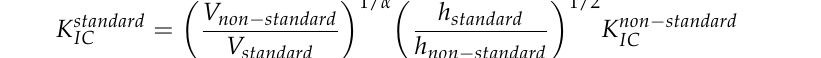
( c ) Figure 13. AE signal–time and stress–time curves of concrete with different graphite powder content during compressive tests. ( a ) C1; ( b ) C2; ( c ) C3. As seen in Figure 13, cumulative ringing counts curve and cumulative energy release curve variation tendencies are approximate and unanimous. Based on the cumulative ringing counts curve, the process of C1 comprises four stages: initial compaction stage (Stage I), stable crack growth stage (Stage II), pre-peak stage (Stage III), and post-peak stage (Stage IV) [28]. For C1 shown in Figure 13a, in Stage I (~18% of the peak load), the cumulative ringing counts curve is not completely linear, but exhibits a little concave downward form. During the early loading of Stage I, the increasing-growing cumulative ringing counts and cumulative energy are from the microcrack closure of the concrete, and afterward, when the micro-cracks are compacted, and the increasing-growing trend is restrained. AE signals then go a little gently before proceeding to the next stage. At Stage II (18~95% of the peak load), the cumulative ringing counts and cumulative energy increase linearly with time, indicating the crack propagation was relative stable. After that, at the pre-peak region of Stage III (~95% of the peak load), with rapid progress in cumulative ringing counts and cumulative energy, there was large propagation of mi- crocracks in the concrete, but almost no appreciable macroscopic crack on the surface. At the post-peak region of Stage IV, with the stress decreasing with time, the cumulative ringing counts and cumulative energy remain at a high level until rapid macroscopic crack propagation occurs. Thus, for concrete specimen without graphite powder, the turning